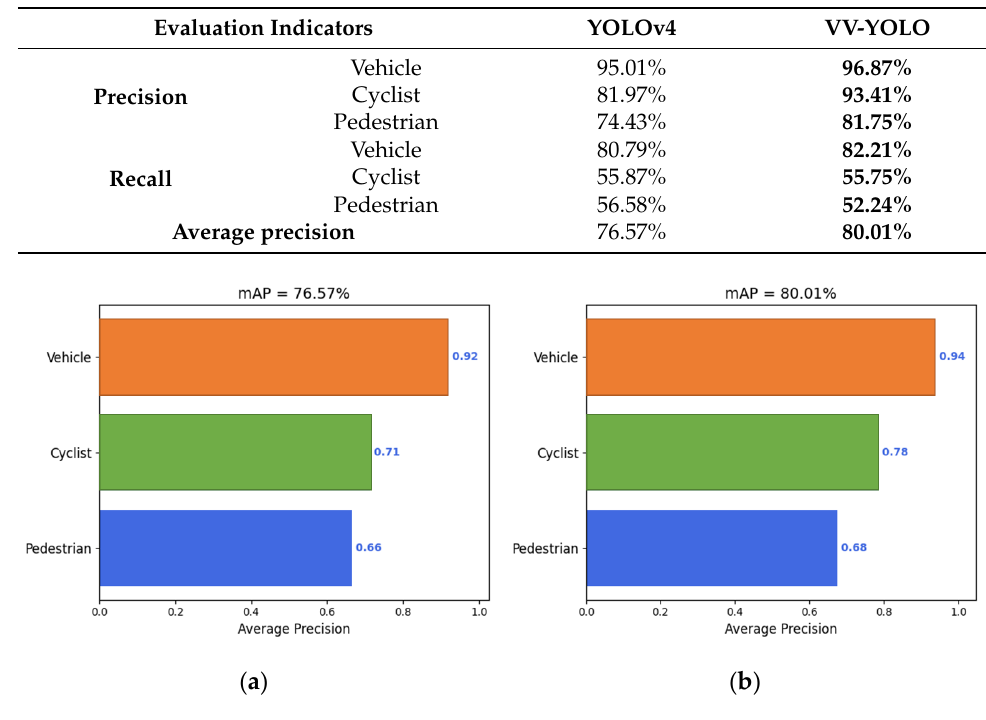
Figure 15. Schematic diagram of average precision: ( a ) YOLOv4; ( b ) VV-YOLO.